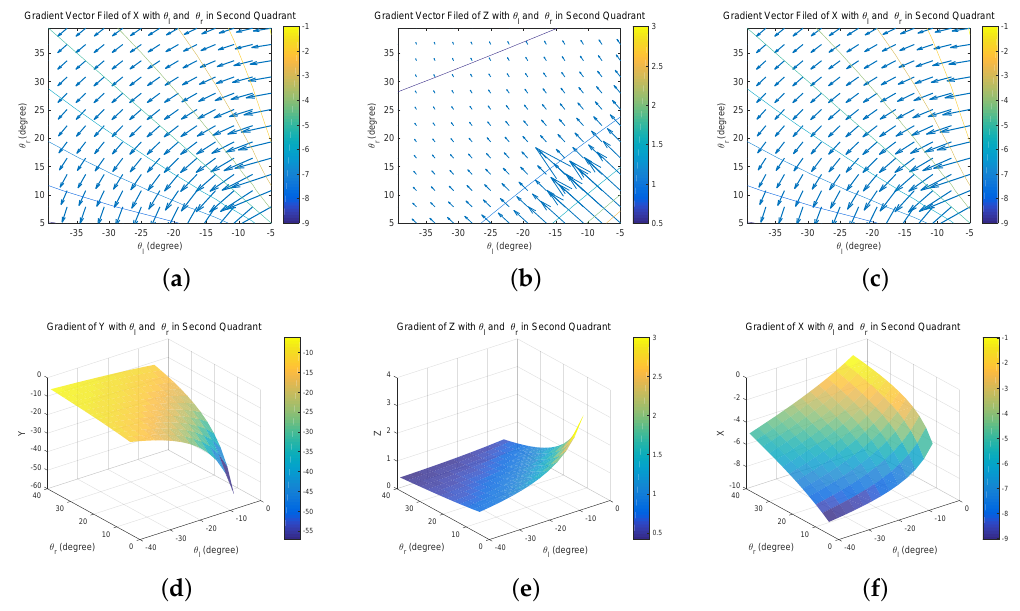
( ψ ) , ∇ y ( ψ ) , and ∇ z ( ψ ) in the second l , ψ r l , ψ r l , ψ r M M M